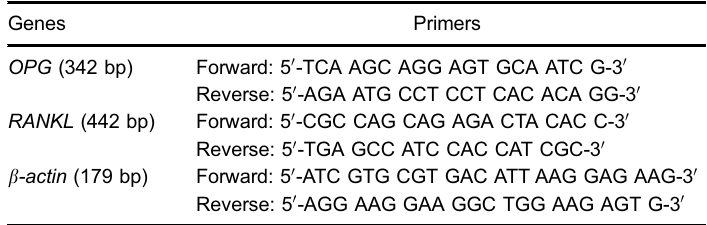
Table 1. Primers used in RT-PCR.